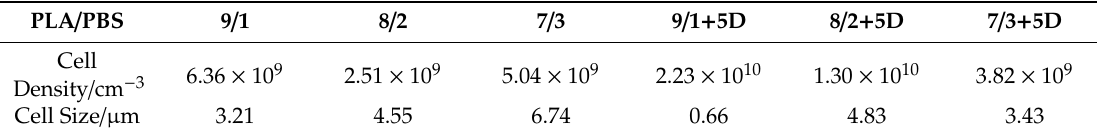
Table 3. Cell characteristic statistics at 140 ◦ C for 10 s.